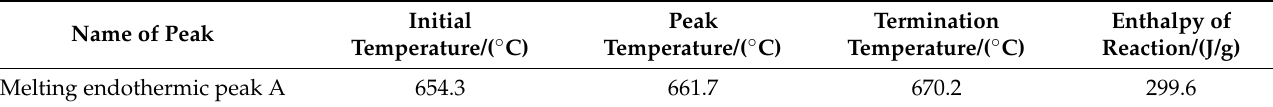
Figure 12. TG/DSC curve of sample Al. A: Endothermic peak. Table 12. Parameters of peak A on DSC curve of sample Al.